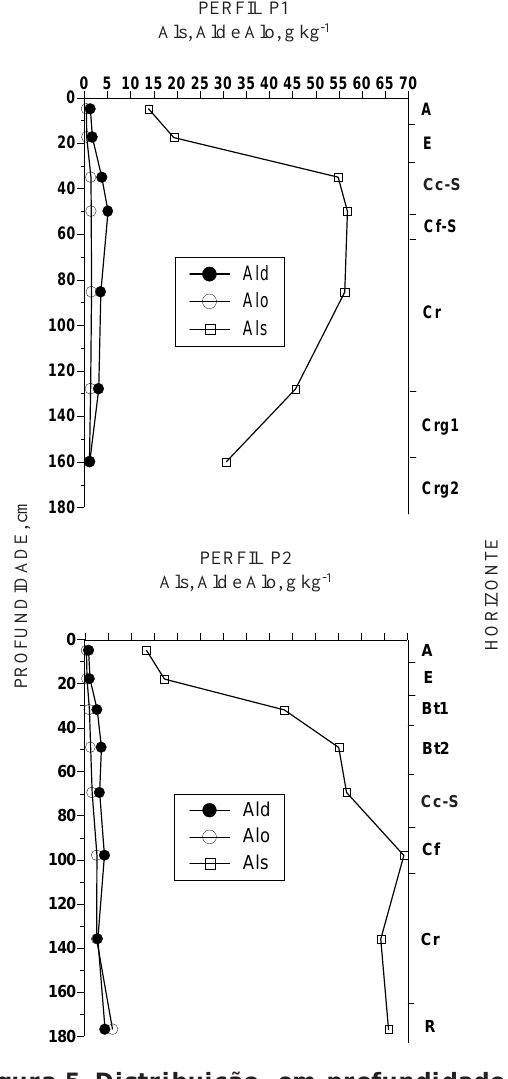
Figura 5. Distribuição, em profundidade, do alumínio extraído por ataque sulfúrico (Al ditionito de sódio (Al (nos horizontes nodulares considerou-se apenas sua matriz